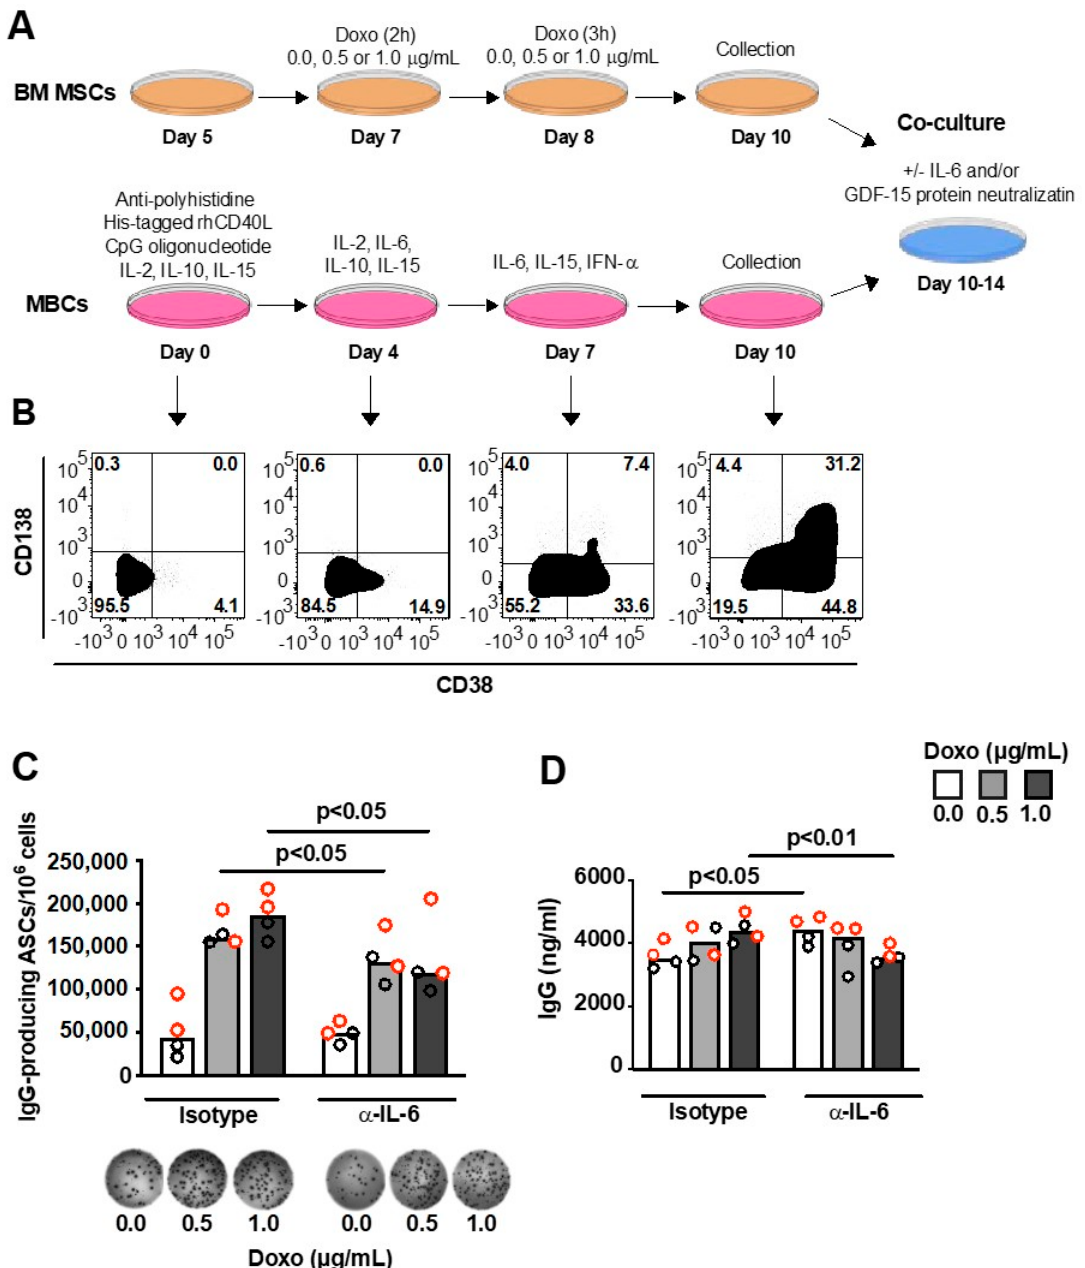
Figure 3. Doxo-exposed primary human BM MSCs sustain a higher number of IgG-producing antibody-secreting cells (ASCs). ( A ) Schematic picture of ASC enrichment following differentiation of memory B-cells (MBCs), and their co-culture with BM MSCs. At day 10, the enriched ASC population (pooled from n = 2 donors) was collected and co-cultured with earlier Doxo-exposed or non-exposed BM MSCs ( n = 2 HC and n = 2 ALL) for additional four days (day 10–14). ( B ) Representative phenotype of ASCs (CD38 + CD138 – and CD38 + CD138 + ) which gradually became enriched in the in vitro culture from day 0 to 4, 7 and 10 of differentiation. ( C ) Representative wells and compiled data of IgG spot-forming ASCs evaluated by ELISPOT after BM MSC and ASC co-culture with or without IL-6 neutralization. ( D ) Soluble IgG levels in BM MSC and ASC co-cultures, with or without IL-6 neutralization. O : Healthy controls, O : Children under treatment for ALL